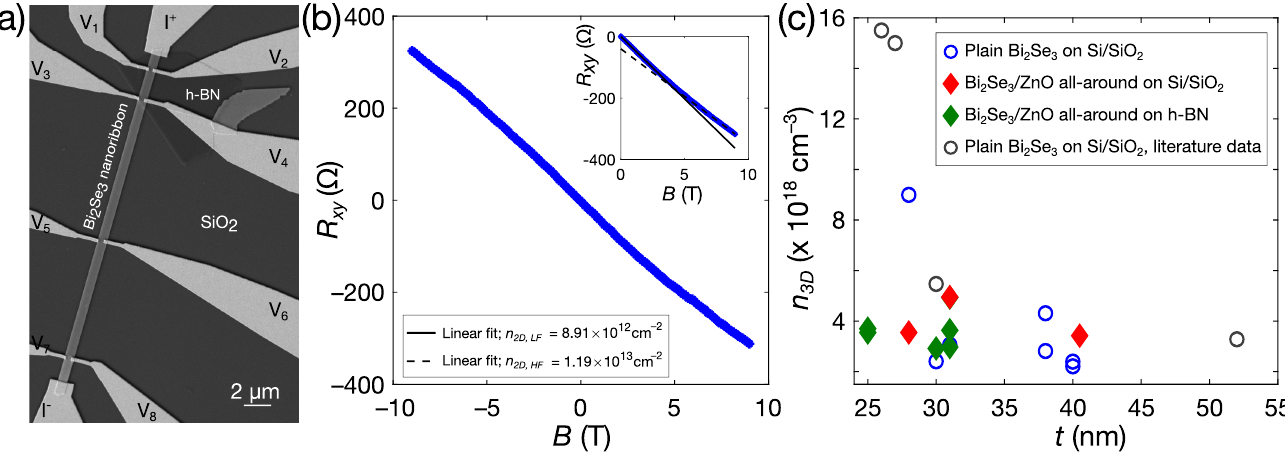
Figure 2. ( a ) SEM image of a Bi 2 Se 3 nanoribbon Hall-bar device; ( b ) Hall resistance R xy ( B ) for the ZnO/Bi 2 Se 3 nanoribbon device A3t (see Table S1), measured at back-gate voltage V g = 0 V. The inset shows anti-symmetrized R xy ( B ) data with linear fit in the 0–2.5 T range (black solid curve), and in the 7–9 T range (black dashed curve); ( c ) Hall carrier density of Bi 2 Se 3 and ZnO/Bi 2 Se 3 nanoribbons, plotted versus the nanoribbon thickness. In the case of the ZnO/Bi 2 Se 3 nanoribbons, total thickness t is reduced by 4 nm, accounting for the two ~2 nm thick ZnO layers. Gray data points correspond to the data from [14]; here, the carrier density is calculated from the same magnetic field range (0–2.5